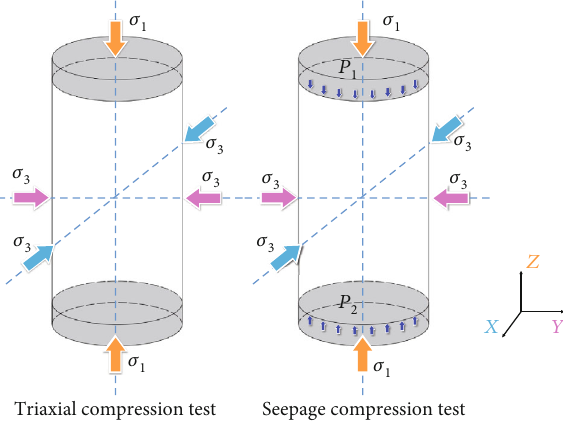
Figure 1: Diagram of the tests ’